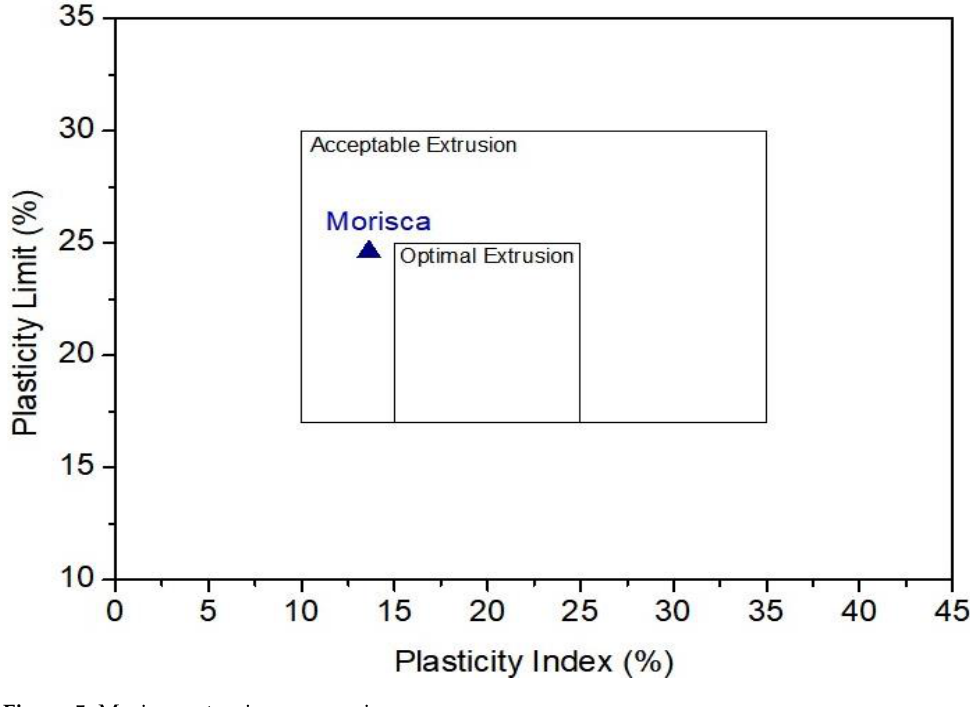
Figure 5. Morisca extrusion prognosis.